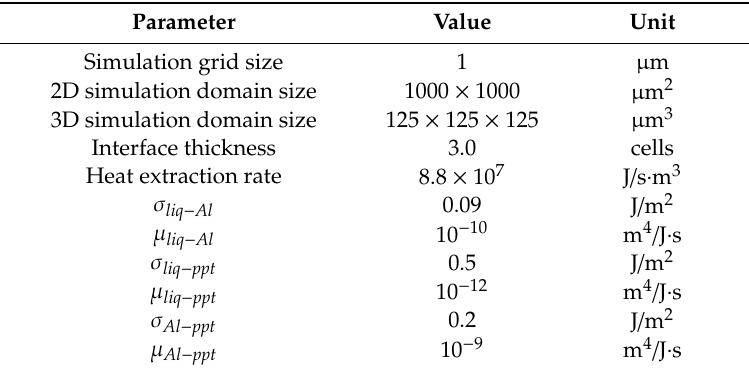
Figure 5. ( a ) Simulated and measured temperature profiles ( b ) 2D simulated microstructural evolution ( c ) observed using EBSD and simulated phase maps in scale-matched form. Table 3. Phase-field simulation